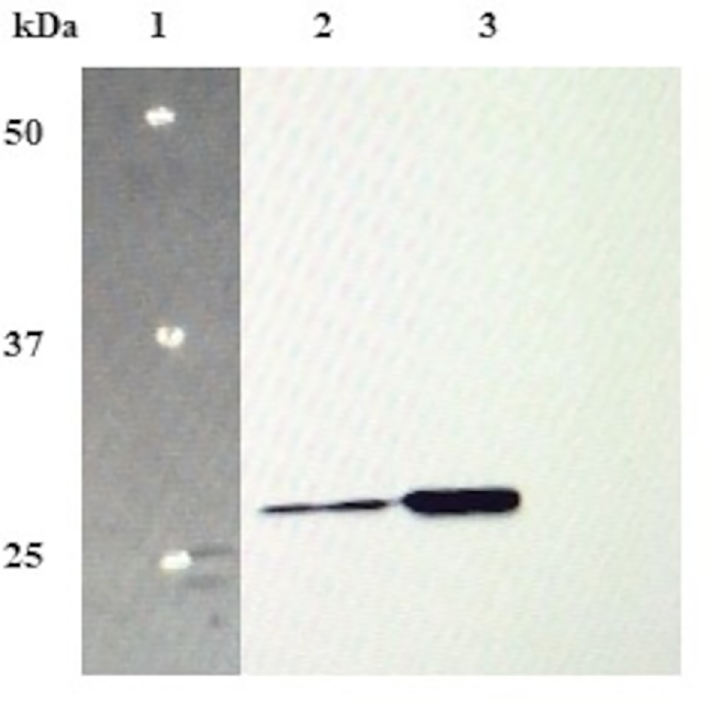
Fig 3. Western blot analysis of Dermatopontin. Lane 1: protein marker; Lane 2: standard DPT; Lane 3: rDPT.